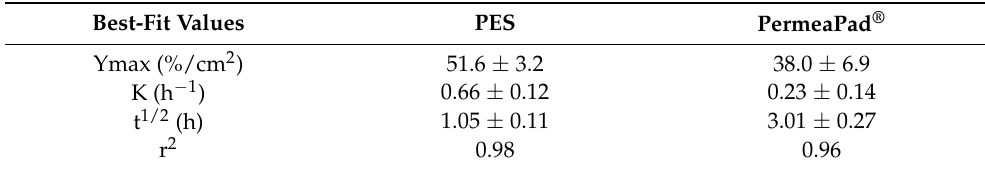
Table 1. Drug release parameters from KT hydrogel according to a first order kinetics. Values represent means ± standard error (n = 3). Best-Fit Values